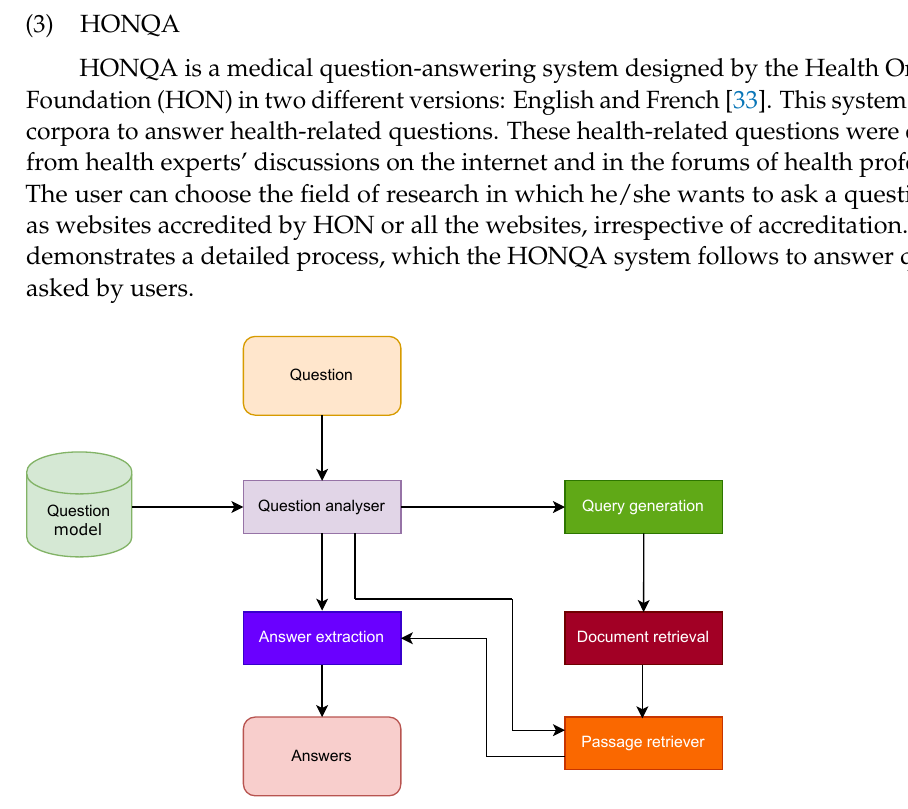
Figure 4. The architecture of HONQA